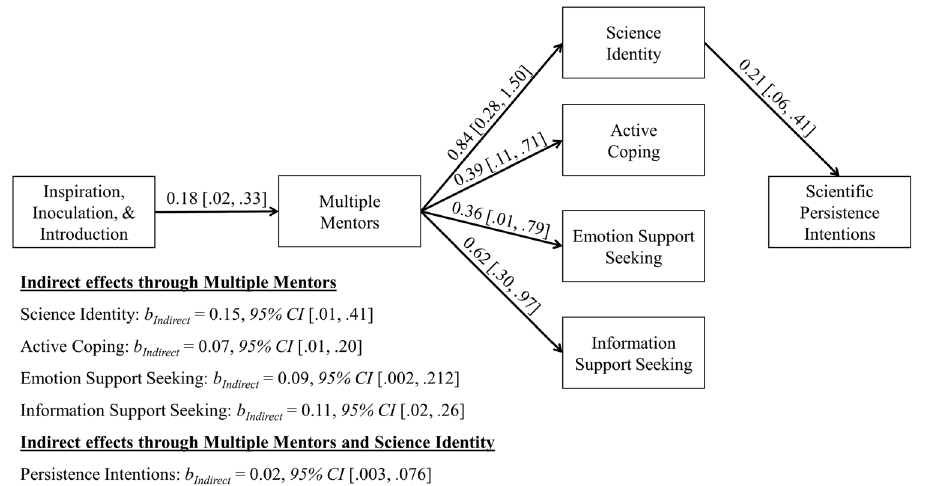
Fig. 3 Indirect effects of being in the “ Inspiration, Inoculation, & Introduction ” group on motivation, coping skills, and persistence intentions through multiple mentorships. Notes: Values outside of brackets represent unstandardized regression/path coef fi cients, while values inside brackets represent the lower and upper limits of bias-corrected bootstrapped 95% con fi dence intervals [lower limit, upper limit]. “ Inspiration, Inoculation, & Introduction ” is a binary indicator of experimental group status (Inspiration, Inoculation, & Introduction group = 1, other type of workshop = 0). “ Multiple mentors ” is a binary indicator of mentor network size (two or more mentors = 1, other type of workshop = 0). For the sake of parsimony, only variables and paths associated with statistically signi fi cant indirect effects of group status on downstream motivational, coping, and persistence intentions are shown here. Complete details are provided in the “ Methods ”